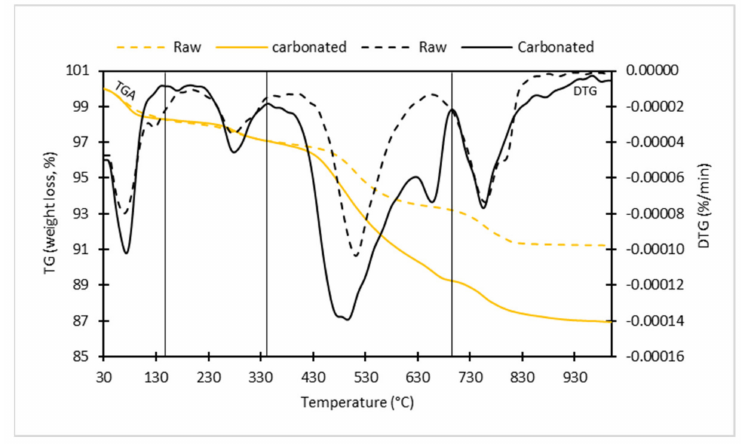
Figure 4. Thermogravimetric (TG) analysis and DTG curve of carbonated Fe − rich mine waste (raw and particle size <38 µ m).